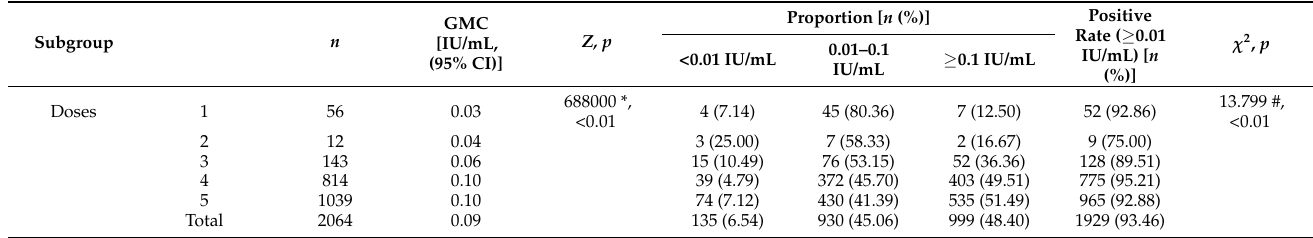
Table 4. Seroprevalence and tetanus antibody level in different